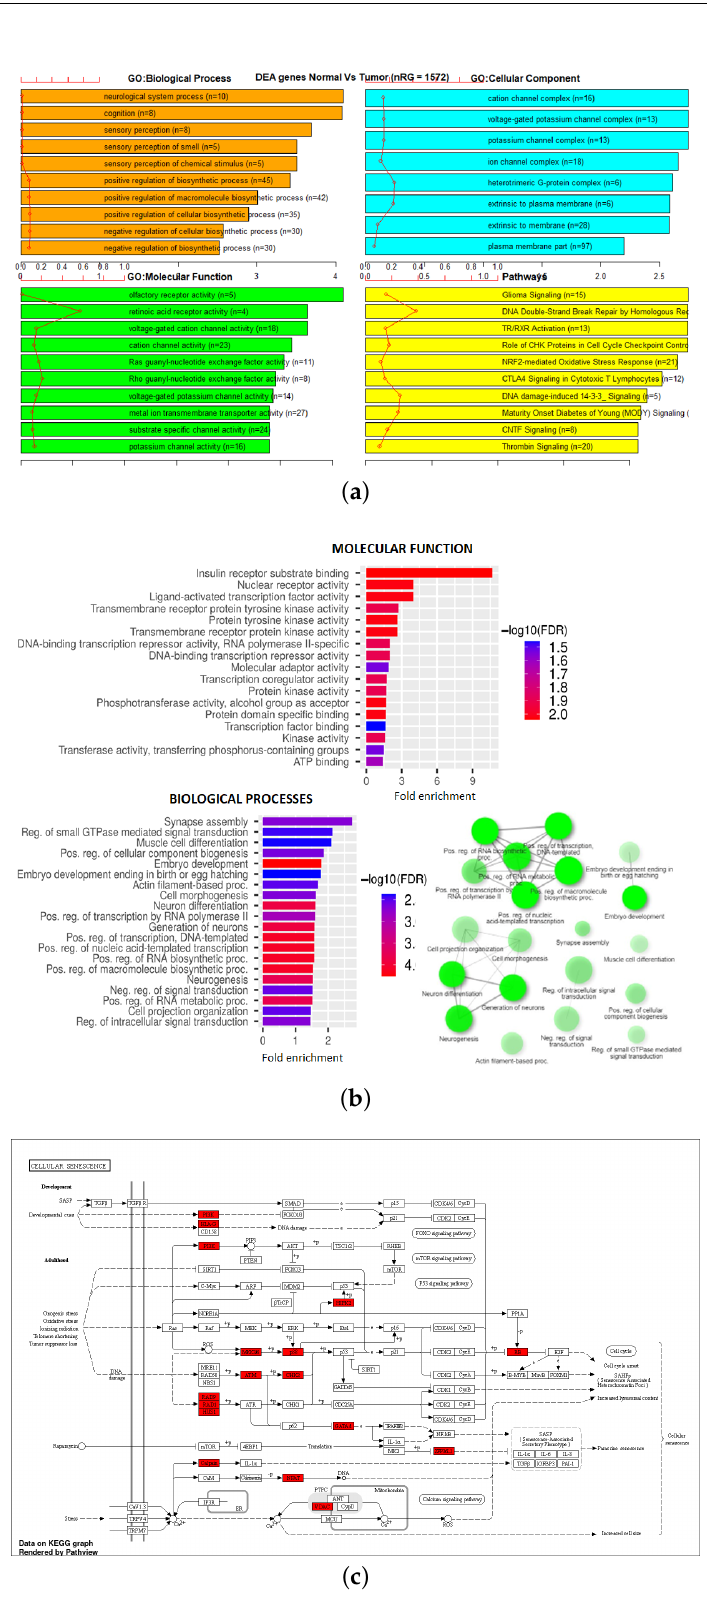
Figure 7. GSEA on reduced markers of 450K SMOTE using ( a ) TCGA EAanalysis where orange represents biological processes, cyan is a cellular component, green is molecular functions, and yel- low represents pathways, ( b ) ShinyGO derived biological processes and molecular functions and network-based interaction of biological processes in green nodes, and ( c ) ShinyGO enriched pathway visualization where red genes are in the gene set